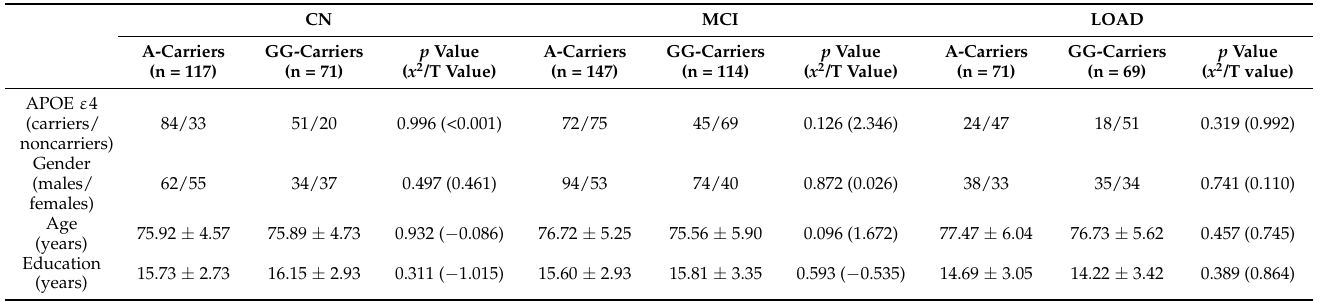
Table 2. The differences in demographic data between A-carriers and GG-carriers of CN, MCI, and LOAD